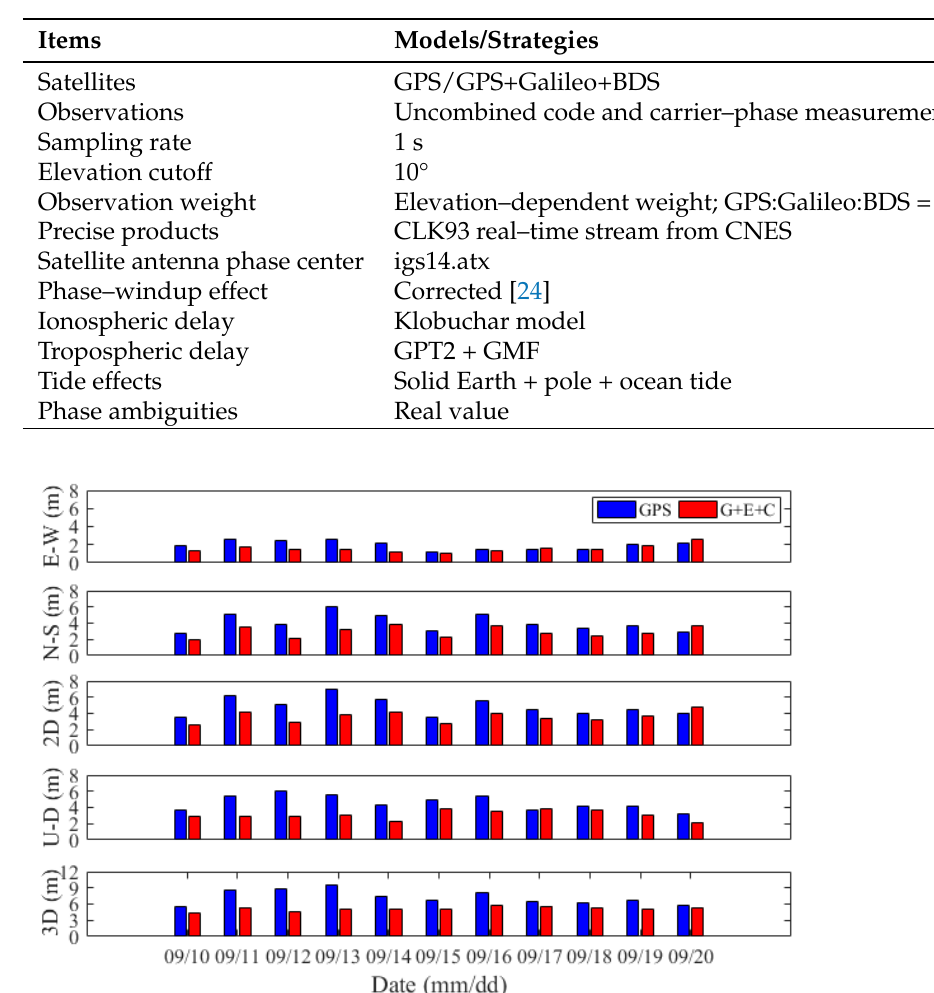
Figure 9. ( a ) SF RT–PPP position errors in the east, north, and up directions for the GPS and multi–GNSS; and ( b ) NSAT and PDOP values for GPS and multi–GNSS from 10:00 to 22:00 on 12 September 2019. Table 5. SF RT–PPP data processing strategy.